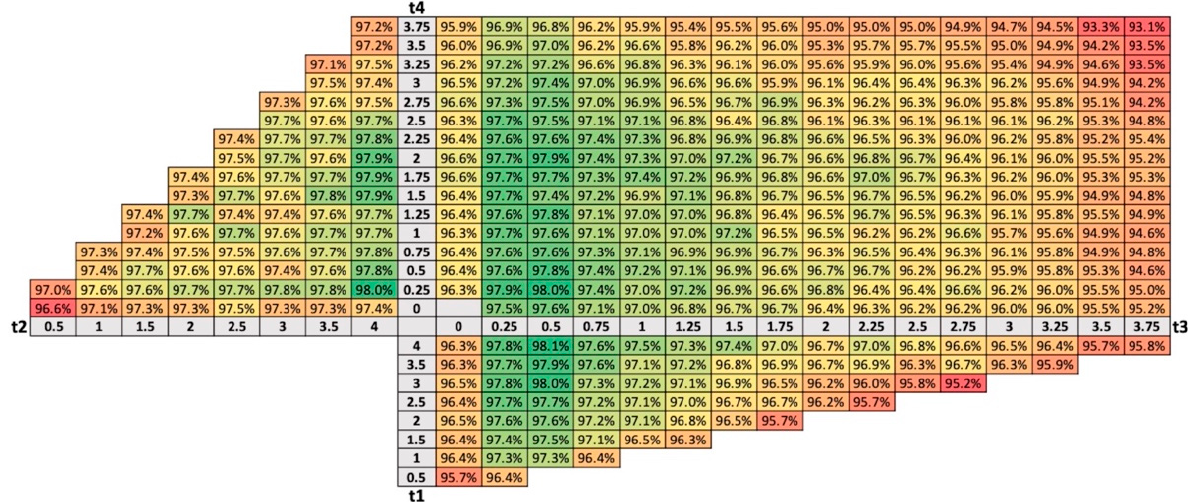
Figure 7. The average of maximal F score from all datasets for each pair of parameters ( t 3 , t 4 ), ( t 2 , t 4 ), ( t 1 , t 3 ). Scores are color